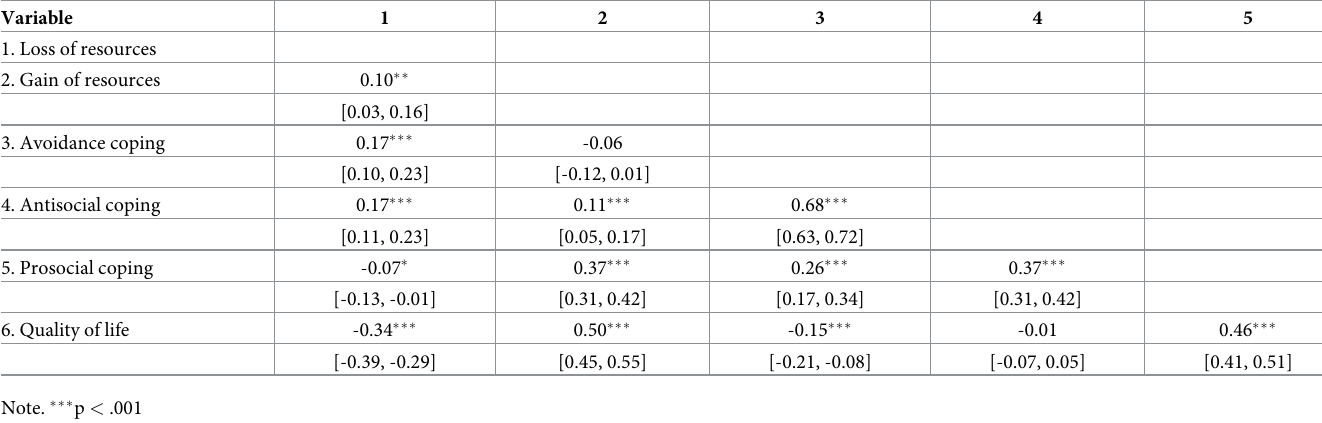
Table 1. Error-free pooled correlations of measurement model with 95% confidence intervals (N = 1037).